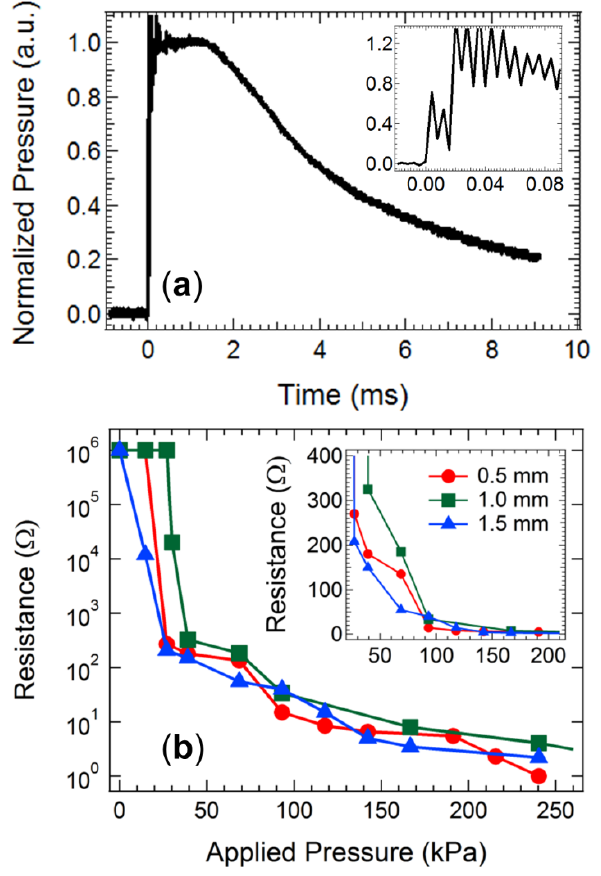
Figure 2. ( a ) The pressure output measured with a transducer and charge amplifier after initiation of the transmission fuse. The inset displays a magnification of the pressure waveform on the time scale up to 80 µs. ( b ) The conductivity response of QTC samples with various thickness to applied pressure. The inset displays a magnified view of the low-pressure region.